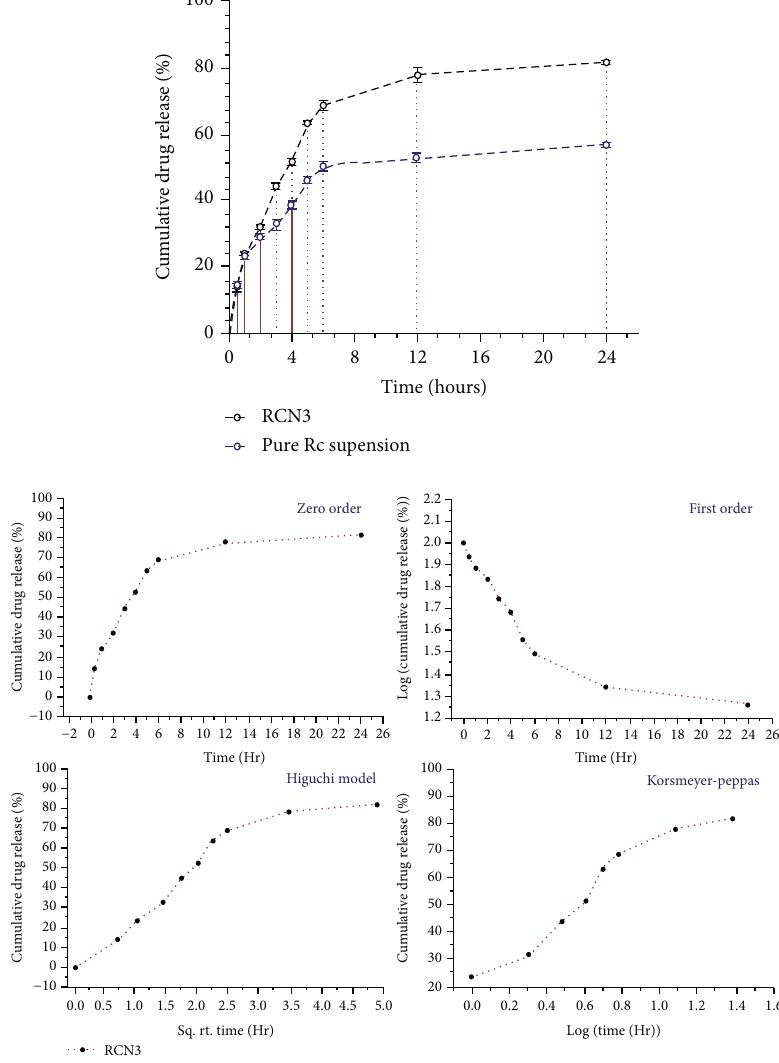
Figure 5: Drug release pro fi le and kinetic model of